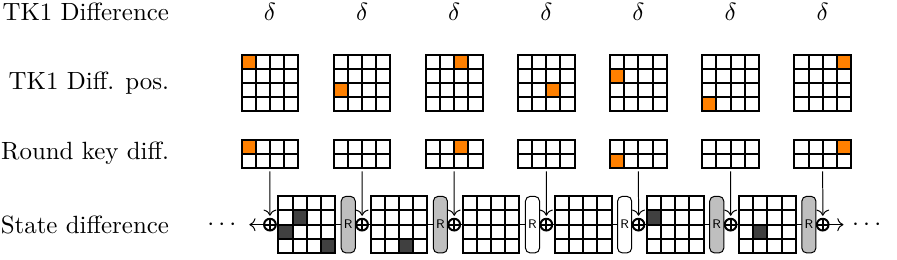
Figure 6: Skinny path construction with a single active tweakey word.